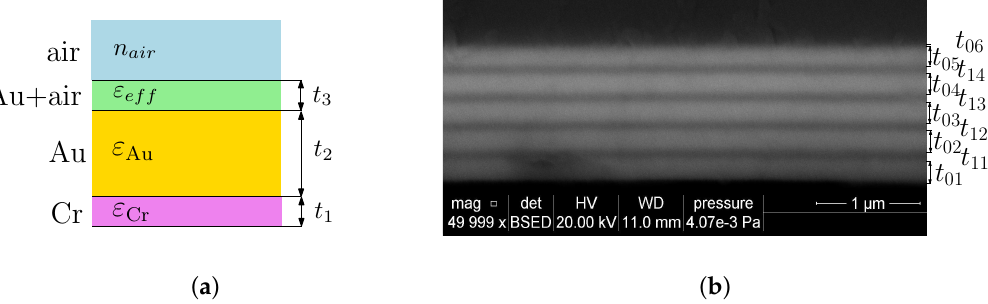
Figure 3. An MPS structure under study ( a ), an SEM photo of an MDS under study ( b